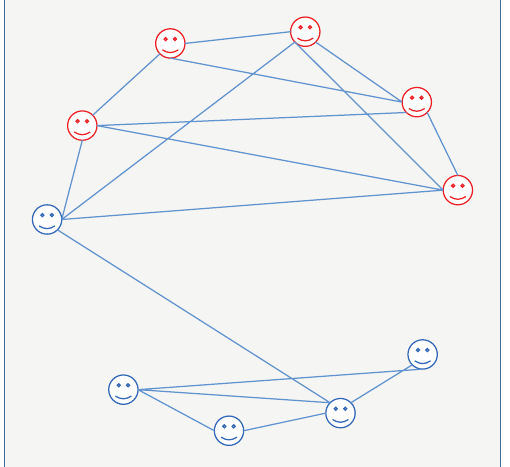
Figure 11: Small-world network, adapted from Ross et al. [135].